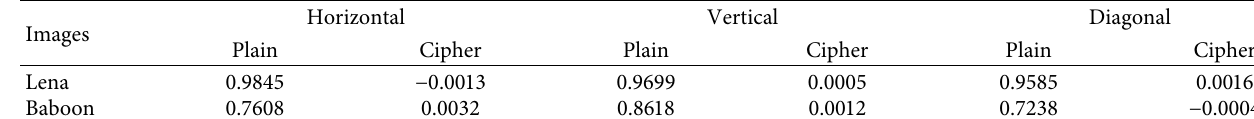
Table 3: Correlation coefficients.